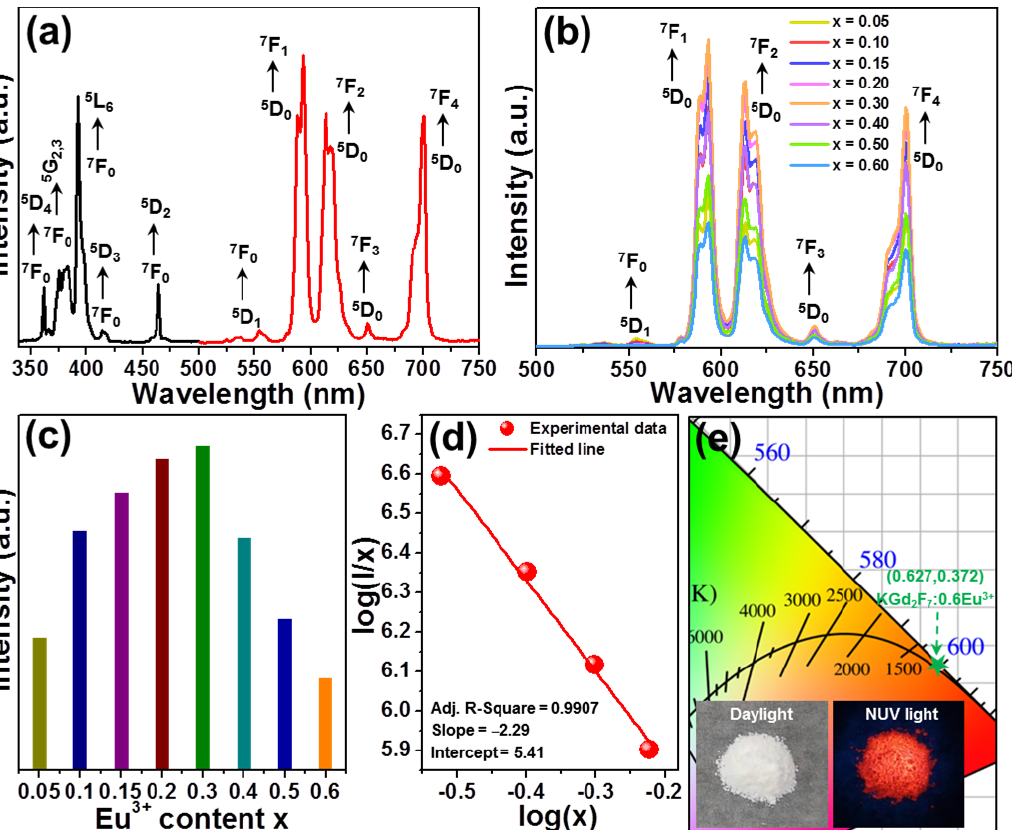
Figure 3. ( a ) Excitation and emission profiles of KGd 2 F 7 :0.60Eu 3+ nanoparticles. ( b ) Emission profiles of KGd 2 F 7 :2 x Eu 3+ nanoparticles. ( c ) Dependence of fluorescence intensity on dopant concentration. ( d ) Plot of log( x ) vs. log( I / x ) for resultant nanoparticles. ( e ) CIE chromaticity diagram of KGd 2 F 7 :0.60Eu 3+ nanoparticles as well as its optical images.